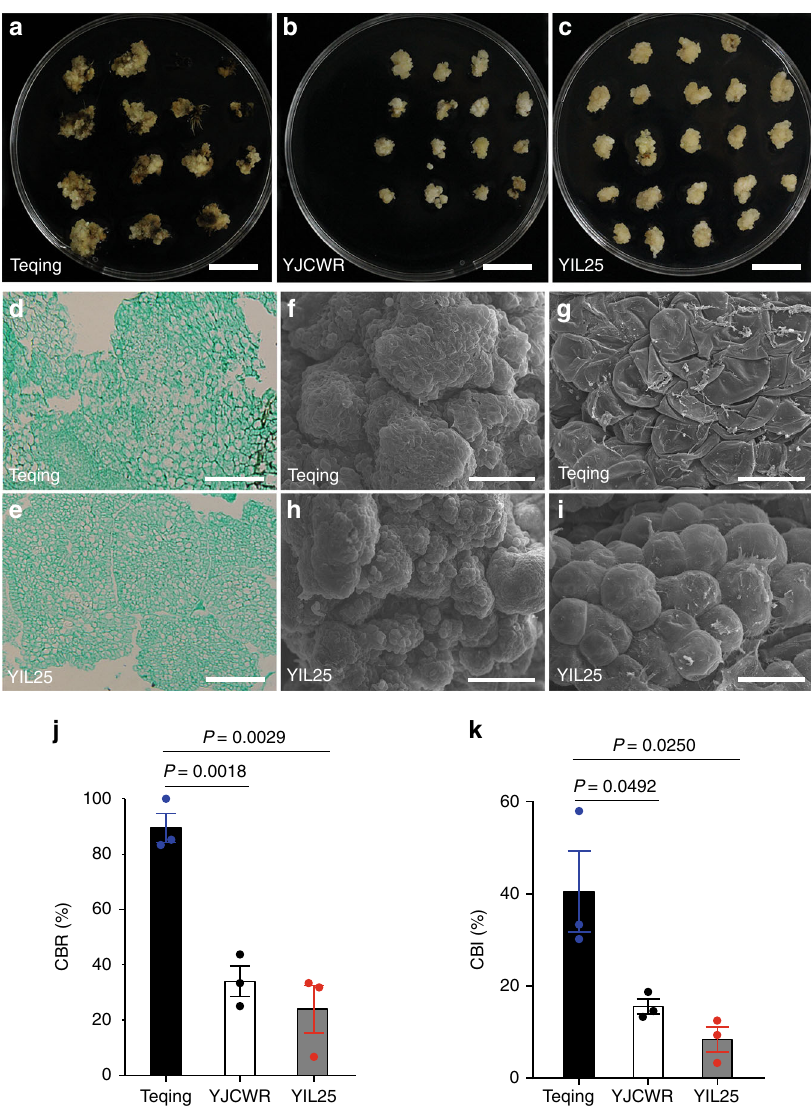
Fig. 1 Phenotypic analysis of calli subcultured for 21 days. a – c Callus browning phenotypes observed in the calli after subculture for 21 days including a indica variety Teqing, b Yuanjiang wild rice ( Oryza ru fi pogon , YJCWR), and c the introgression line YIL25. Scale bars, 2 cm. d , e Paraf fi n sections of d Teqing and e YIL25. Scale bars, 100 μ m. f – i Scanning electron microscopy of Teqing and YIL25 calli. f Teqing calli. Thirty calli each from Teqing and YIL25 were collected for analysis of paraf fi n sections and scanning electron microscopy. Scale bars, 300 μ m. g Enlarged from ( f ). Scale bars, 40 μ m. h YIL25 calli. Scale bars, 300 μ m. i Enlarged from ( h ). Scale bars, 40 μ m. j , k Comparison of the CBR and CBI values of various calli. Values in ( k , l ) are means ± SE ( n =